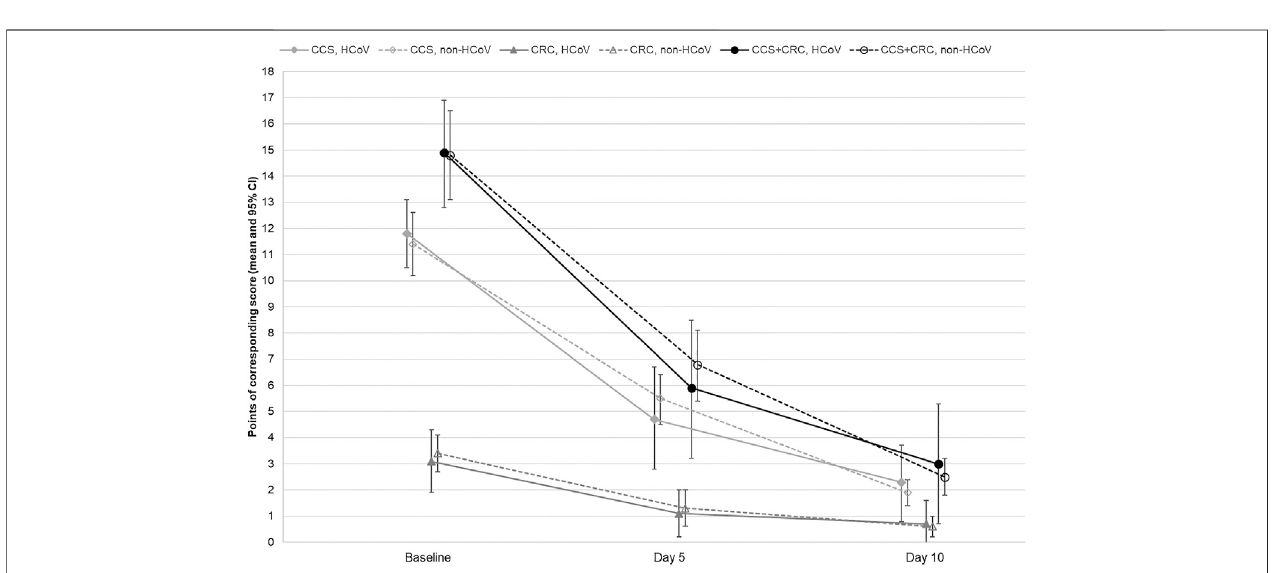
FIGURE 1 | Course of the common cold symptoms (CCS), further common cold relevant complaints (CRC) and overall symptom score (CCS + CRC) in the HCoV andnon-HCoVsubsetsduringthetrial.CCS,HCoV:CCSinvestigatorratingofpatientstestedpositiveforatleastoneHCoV;CCS,non-HCoV:CCSinvestigatorratingof patients tested positive for viruses other than HCoV; CRC, HCoV: CRC investigator rating of patients tested positive for at least one HCoV; CRC, non-HCoV: CRC investigatorratingofpatientstestedpositiveforvirusesotherthanHCoV;CCS+CRC,HCoV:CCS+CRCtotalscoresubsetpatientstestedpositiveforatleastone HCoV; CCS + CRC, non-HCoV: CCS + CRC total score subset patients tested positive for viruses other than HCoV.